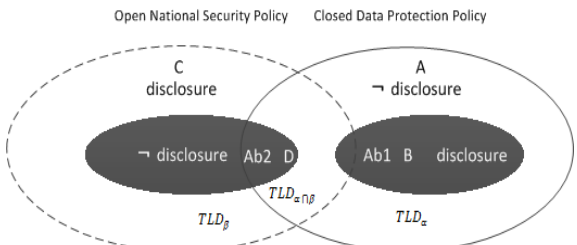
Figure 9. The final PII dataset disclosure is compliant with privacy protection and national security policies following by the priority ordering default